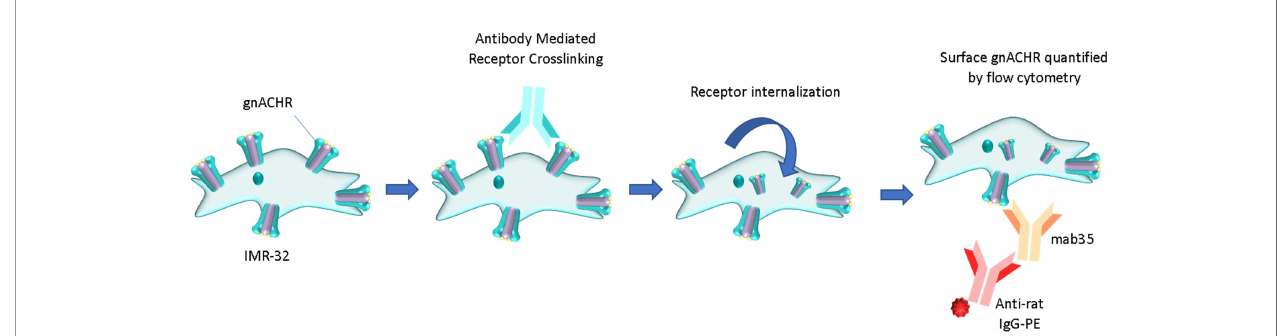
FIGURE 1 | Pathology of autoantibody-induced cell surface receptor crosslinking and internalization (immunomodulation). The remaining surface receptors can be comparatively enumerated fl ow cytometrically. PE,